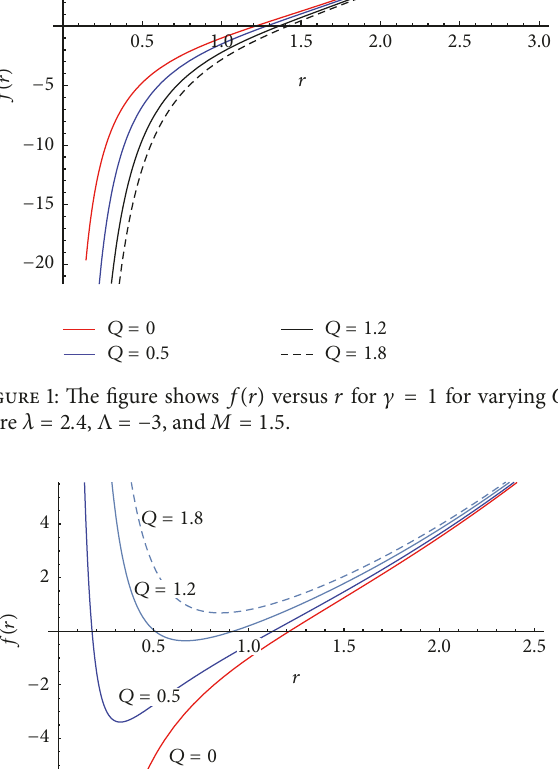
Figure 4: The figure shows 𝑇 versus 𝑆 for 𝛾 = −1 for varying 𝑄 . Here 𝜆 = 2.4 , Λ = −3 . The top dashed curve is at 𝑄 = 0 and the rest have 𝑄 = 0.6𝑄 𝑄 1.2𝑄 𝑄 = 0.12346 𝑐 , 𝑐 , 𝑐 , where 𝑐